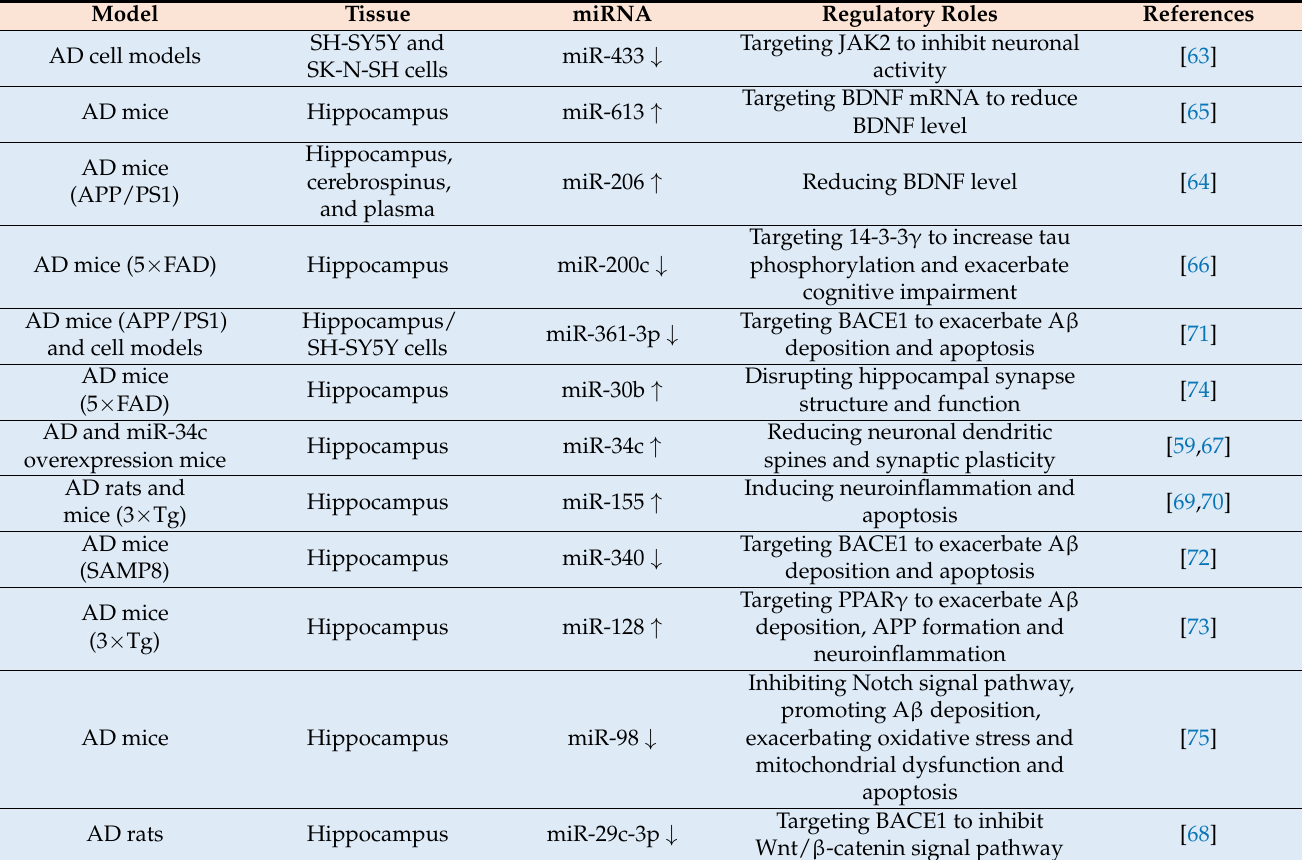
Table 2. miRNAs involving the regulation of AD in animal and cell model